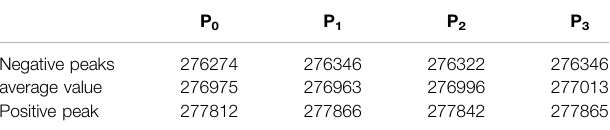
TABLE 3 | Pressure pulsation at each monitoring